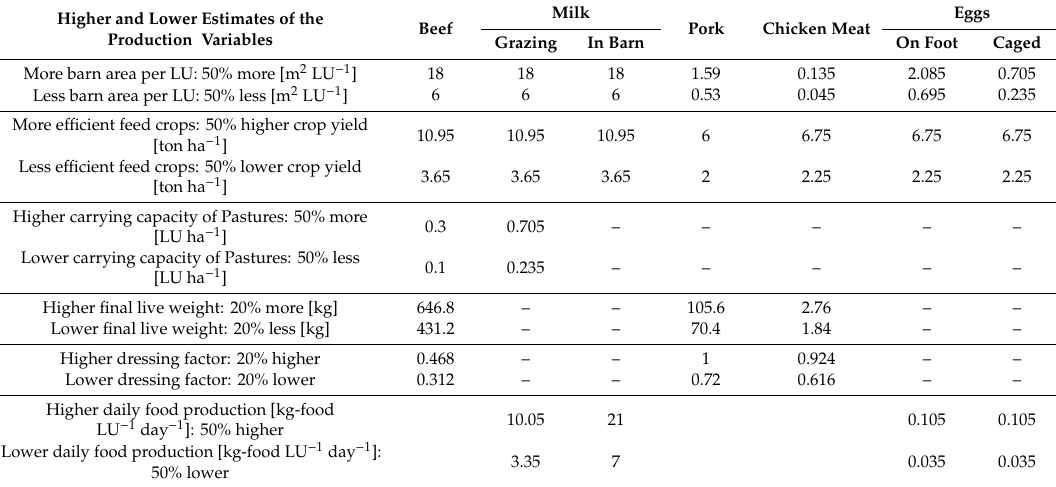
Table 8. Values of the production variables to perform the sensitivity analysis.